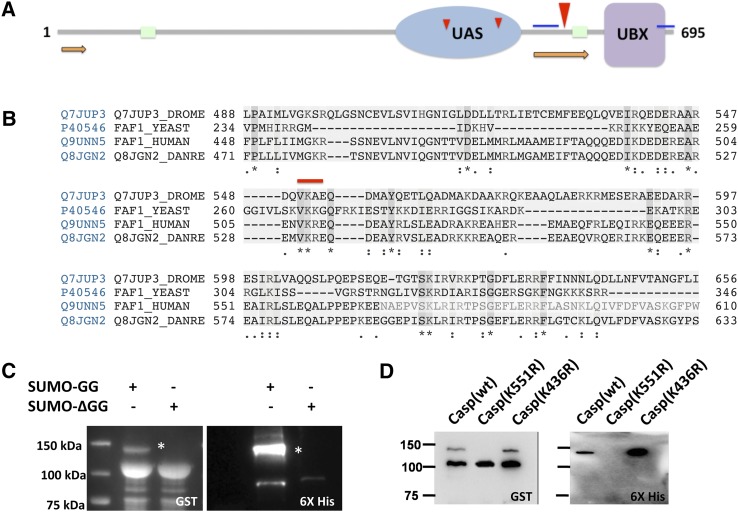
Casp/FAF-1 SUMOylation. (A) Domain structure of Drosophila FAF1. The UAS and UBX domains are marked with potential SUMOylated sites (red arrowheads). The largest arrowhead (K551) has a consensus small ubiquitin-like modifier (SUMO) acceptor site sequence. The gray line indicates disordered regions, green boxes are low-complexity regions, whereas the orange bars indicate regions with predicted helical structure. (B) Alignment of FAF1 proteins from Drosophila, yeast, human, and zebrafish. The figure shows a section of the aligned sequences that contains the predicted SUMO acceptor site (VK551AE) and is conserved from yeast to man. (C) Casp is SUMOylated when tested using the in bacto system. An additional band (*) is seen for GST-SUMO in the presence of activated SUMO (SUMO-GG) but not when SUMO-ΔGG, an inactive form of SUMO that cannot conjugate is used in the SUMOylation assay. (D) K551 is the SUMO acceptor site in Casp. A Casp(K551R) mutation leads to a loss of the SUMO band while a Casp(K436R) mutation does not affect SUMOylaton. The assay is carried out using in bacto SUMOylation.